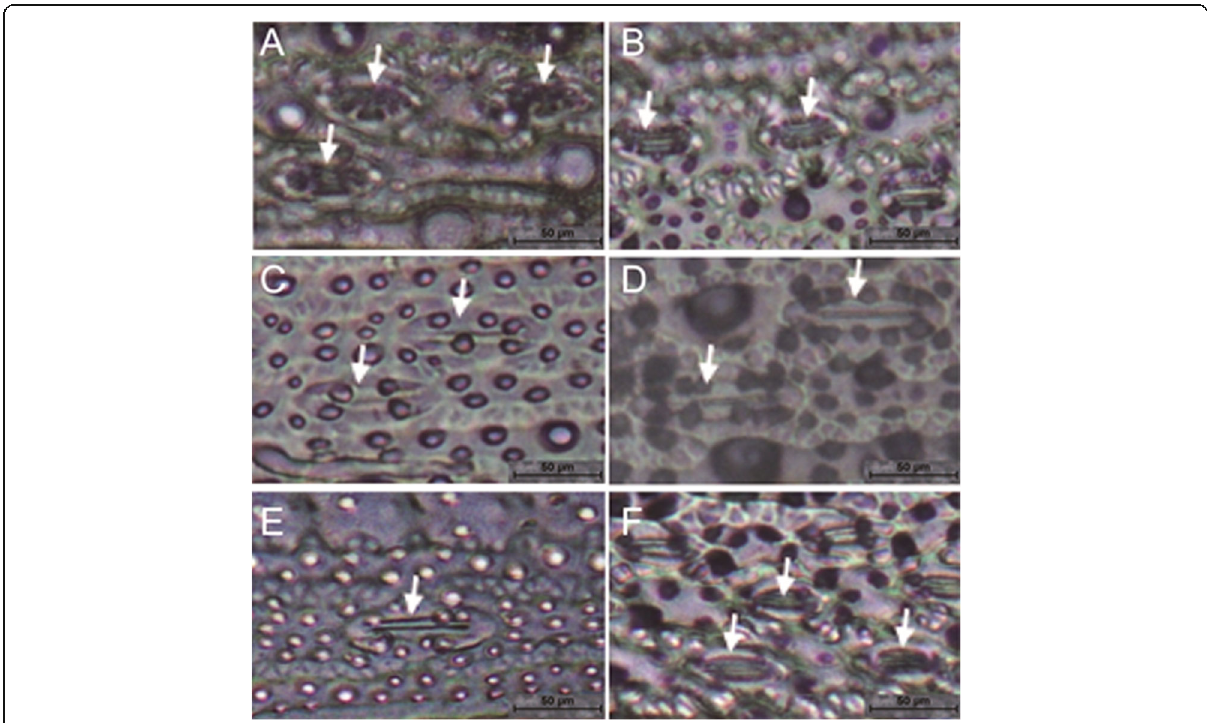
Fig. 3 Guard cells of ‘ Zhaxima ’ , ‘ Nanjing 46 ’ , F1 hybrids, and regenerated plants. a female parent; b male parent; c F1 hybrid; d type 1 plants (height: 72.1 ± 4.5 cm); e type 2 plants (height: 128.8 ± 2.7 cm); f type 3 plants (height: 58.9 ± 1.4 cm)